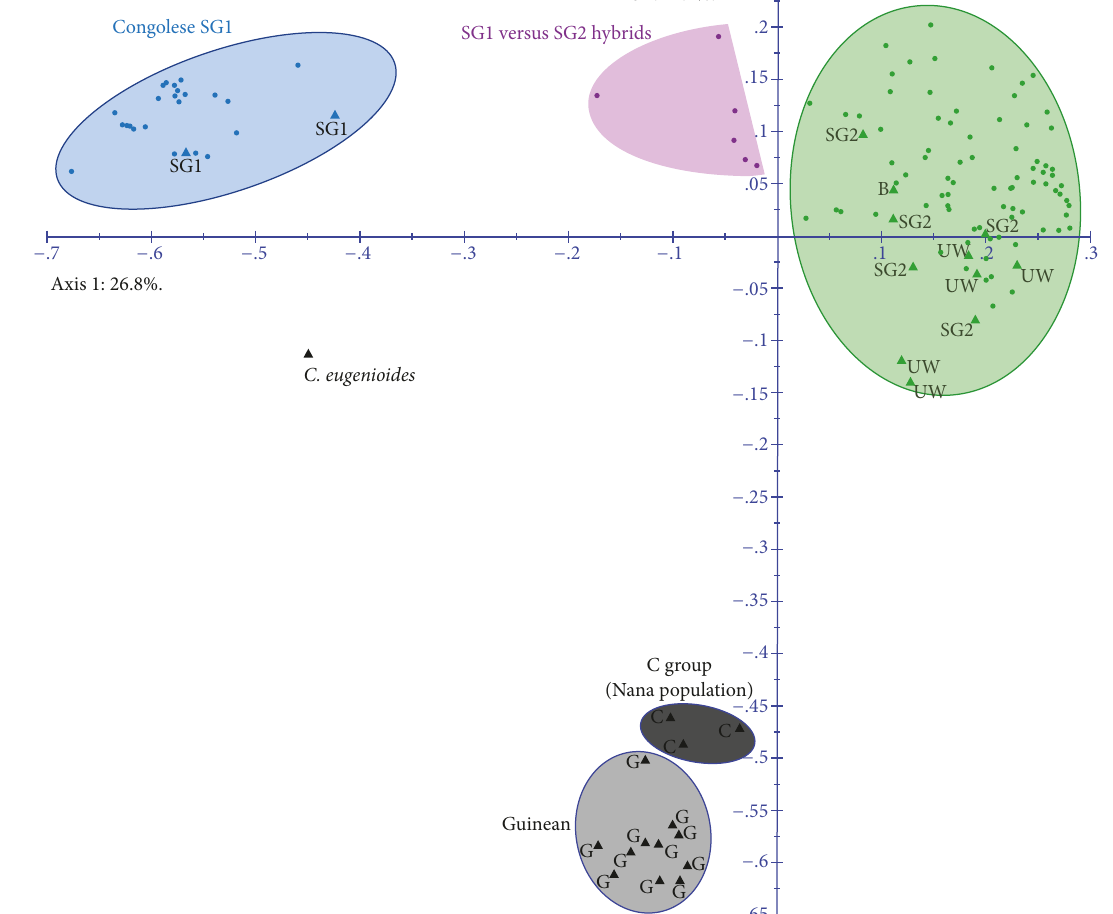
Figure 2: Principal coordinates analysis based on the dissimilarity matrix, calculated using 12 SSR markers for 138 individual genotypes (29 controls and 109 genotypes from